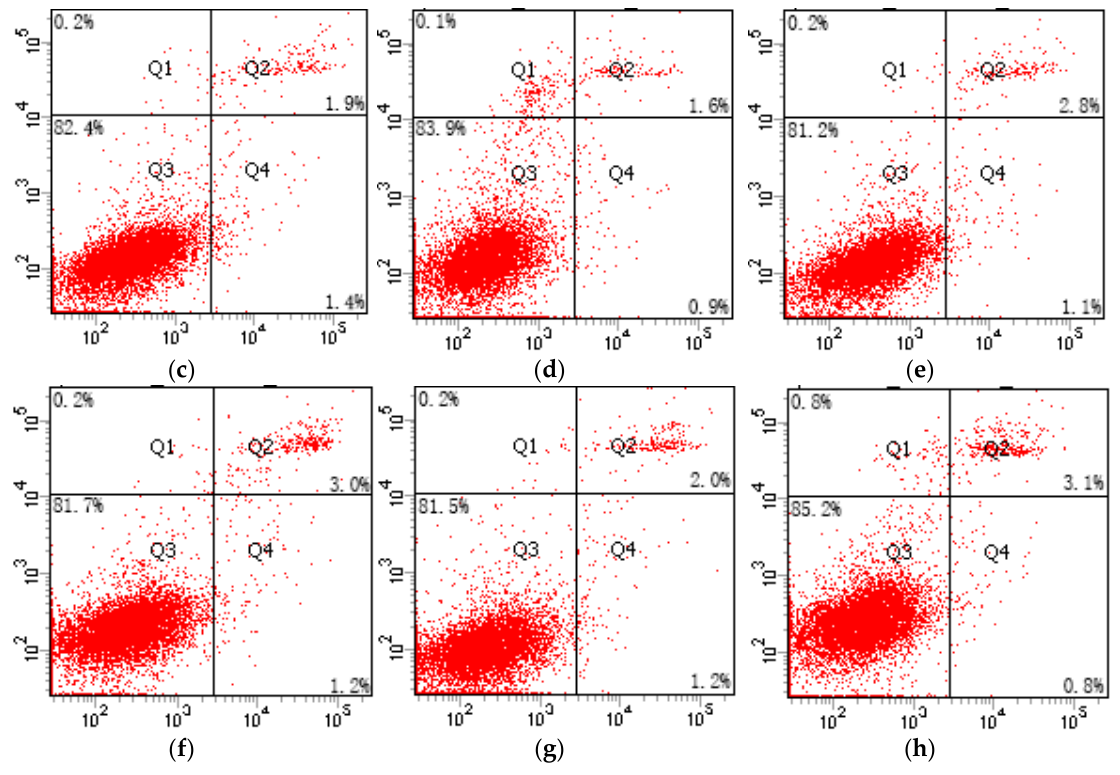
Figure 5. Effect of SFN on the apoptosis of Cd ‐ induced TM4 cells. ( a ) Control group; ( b ) Cd group; ( c ) SFN0.625 group; ( d ) SFN2.5 group; ( e ) SFN10 group; ( f ) Cd + SFN0.625 group; ( g ) Cd + SFN2.5 group; ( h ) Cd + SFN10 group.